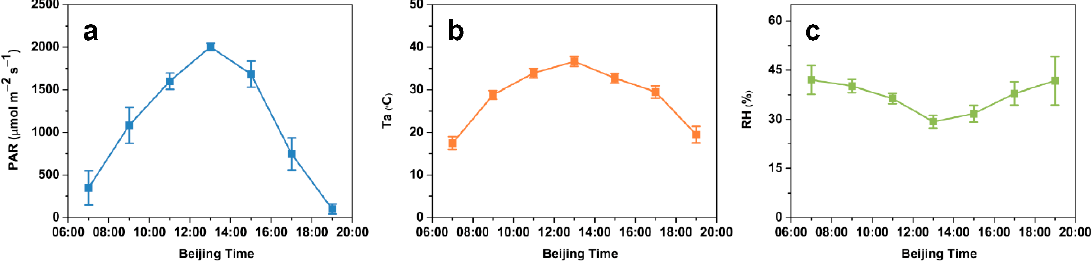
Figure 1. Diurnal time course of the photosynthetically active radiation (PAR) ( a ), air temperature (Ta) ( b ), and air relative humidity (RH) ( c ). The data are presented as mean ± standard error (SE) of three independent experiments.